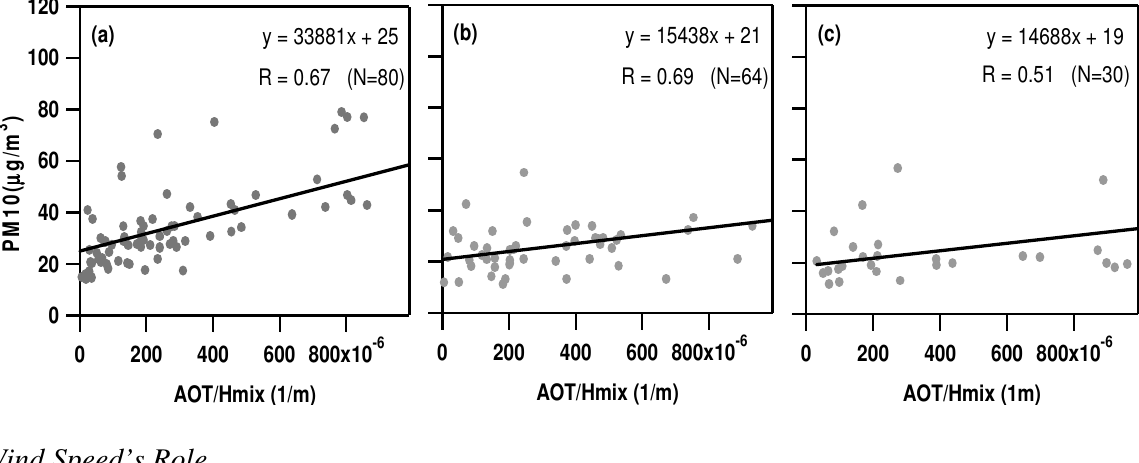
Figure 13. Scatterplot of Guagnano-PM10 mass concentrations versus clear-sky AOTs/Hmix values for (a) 2006, (b) 2007, and (c) 2008. Slope, intercept and linear correlation coefficient ( R ) are also given in each plot in addition to the total number of data points ( N ).